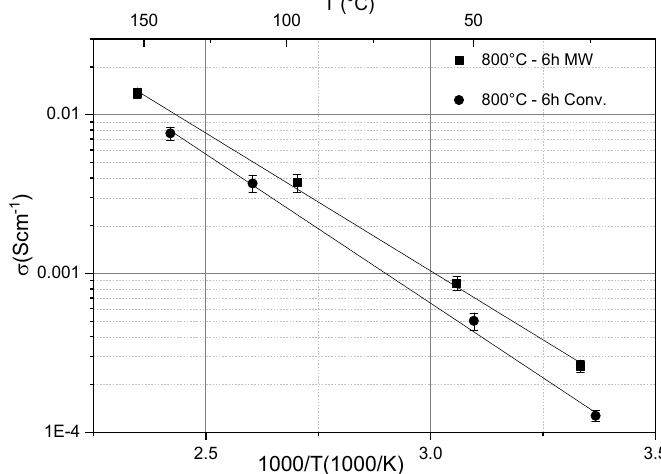
Figure 4. Ionic conductivity of LAGP glass-ceramics samples heat-treated at 800 ◦ C for 6 h using 30 GHz microwave and conventional heating [92].